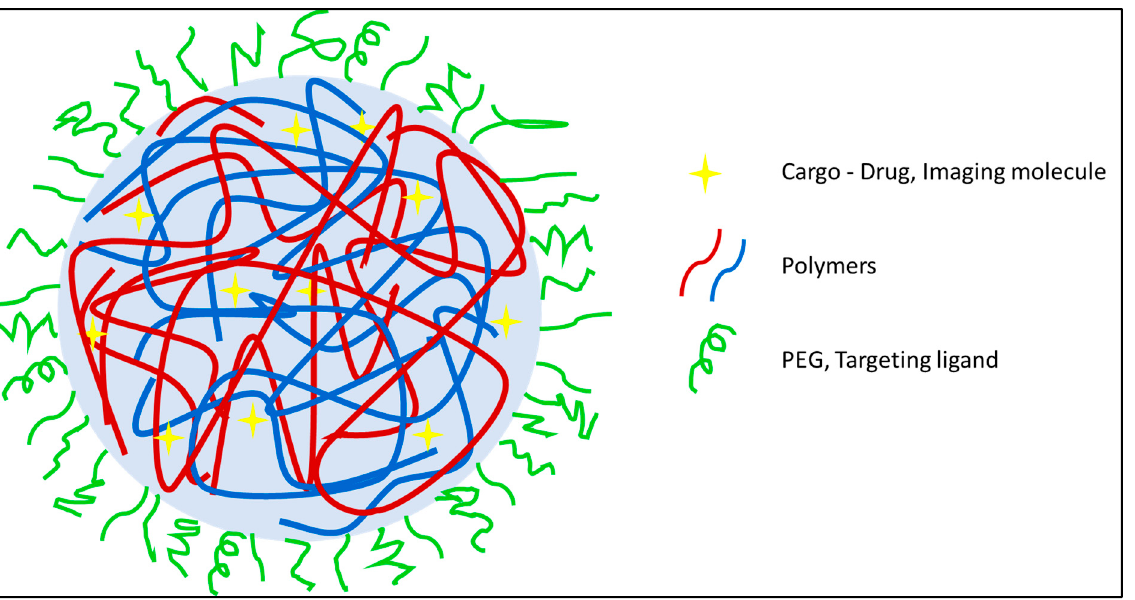
Figure 3. Polymeric nanoparticle complex with random polymer (blue and maroon) coils and a modifiable surface PEGylated surface here (green)). They can encapsulate/hold the payload (yellow star) in the polymer matrix.